Question: Write a descriptive caption for this figure.
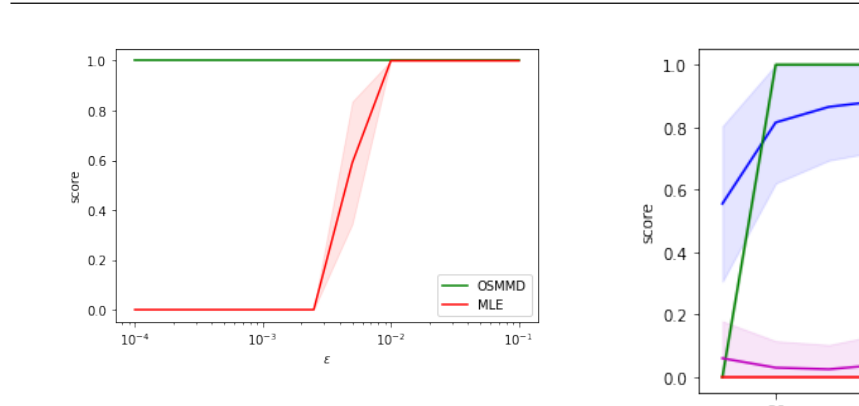
Answer: MLE vs MMD as a function of ε for covari- ance estimation. See Equation (6).